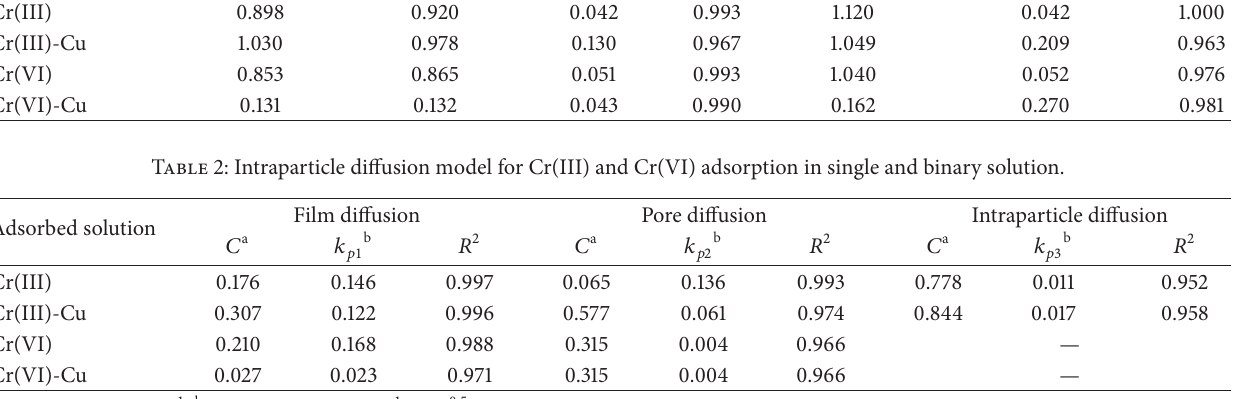
Table 1: Comparison of rate constants calculated based on pseudofirst-order and pseudosecond-order models. Adsorbed solution